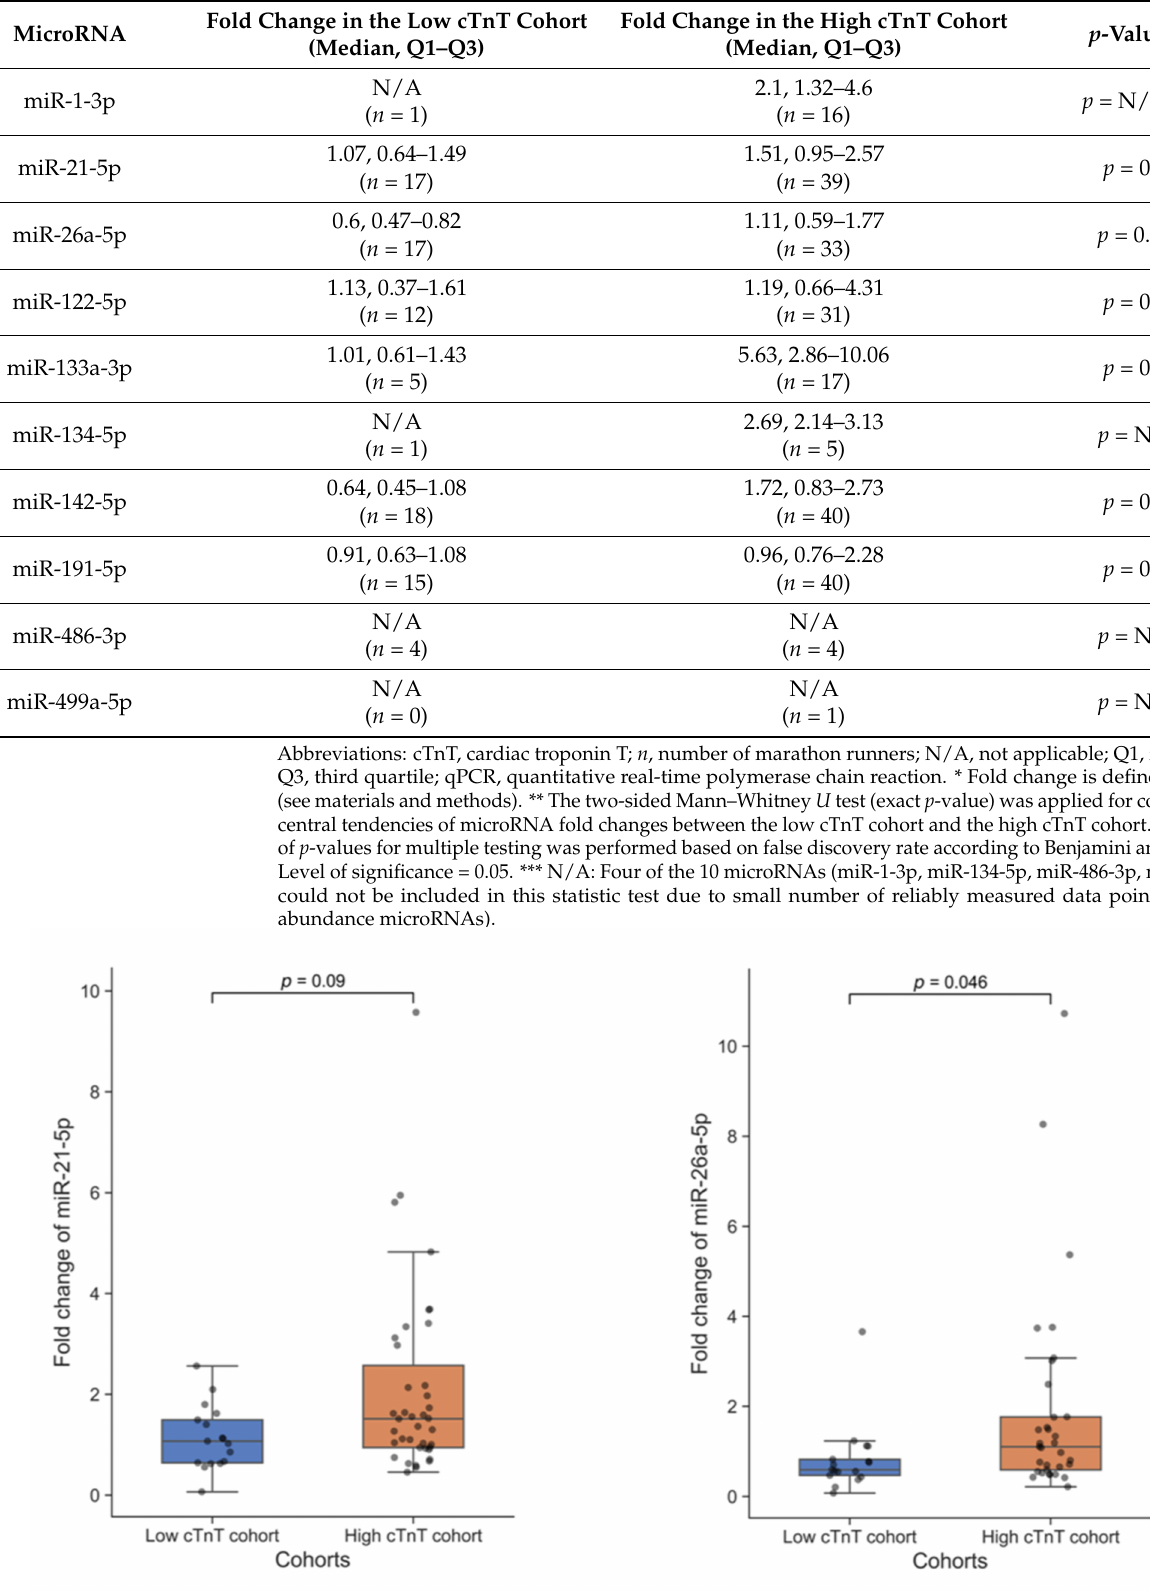
Table 4. Difference of central tendencies of microRNA fold changes * from